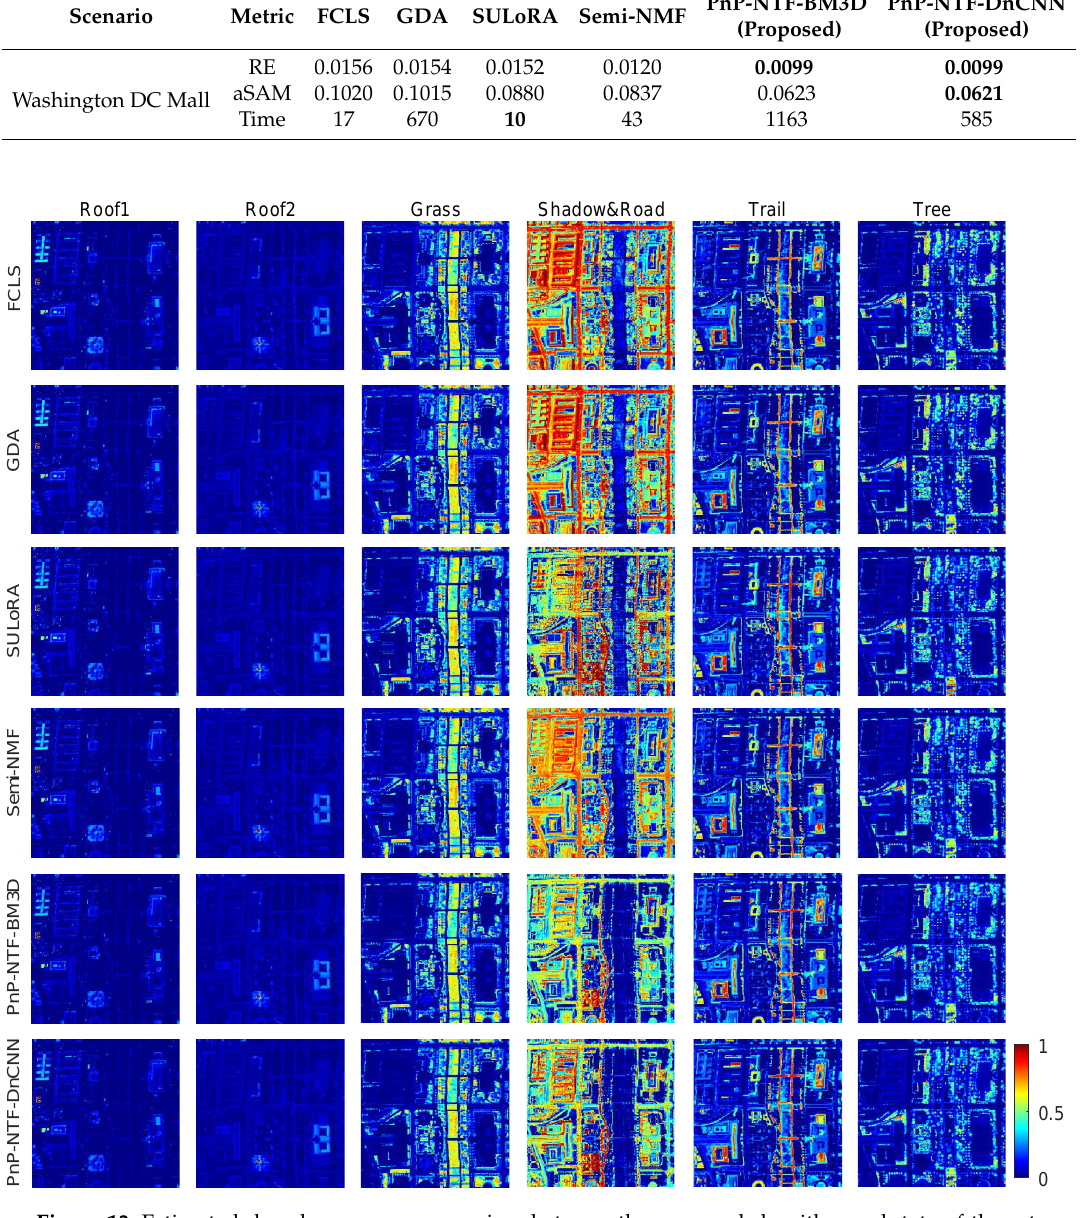
Figure 13. Estimated abundance maps comparison between the proposed algorithm and state-of-the-art algorithms on Washington DC Mall